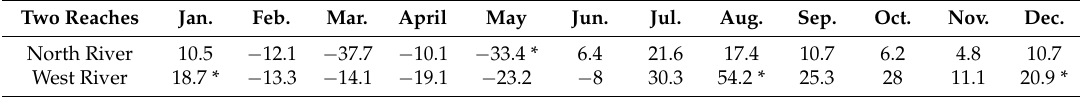
Table 2. Monthly streamflow change due to dam construction in the JRW (%).